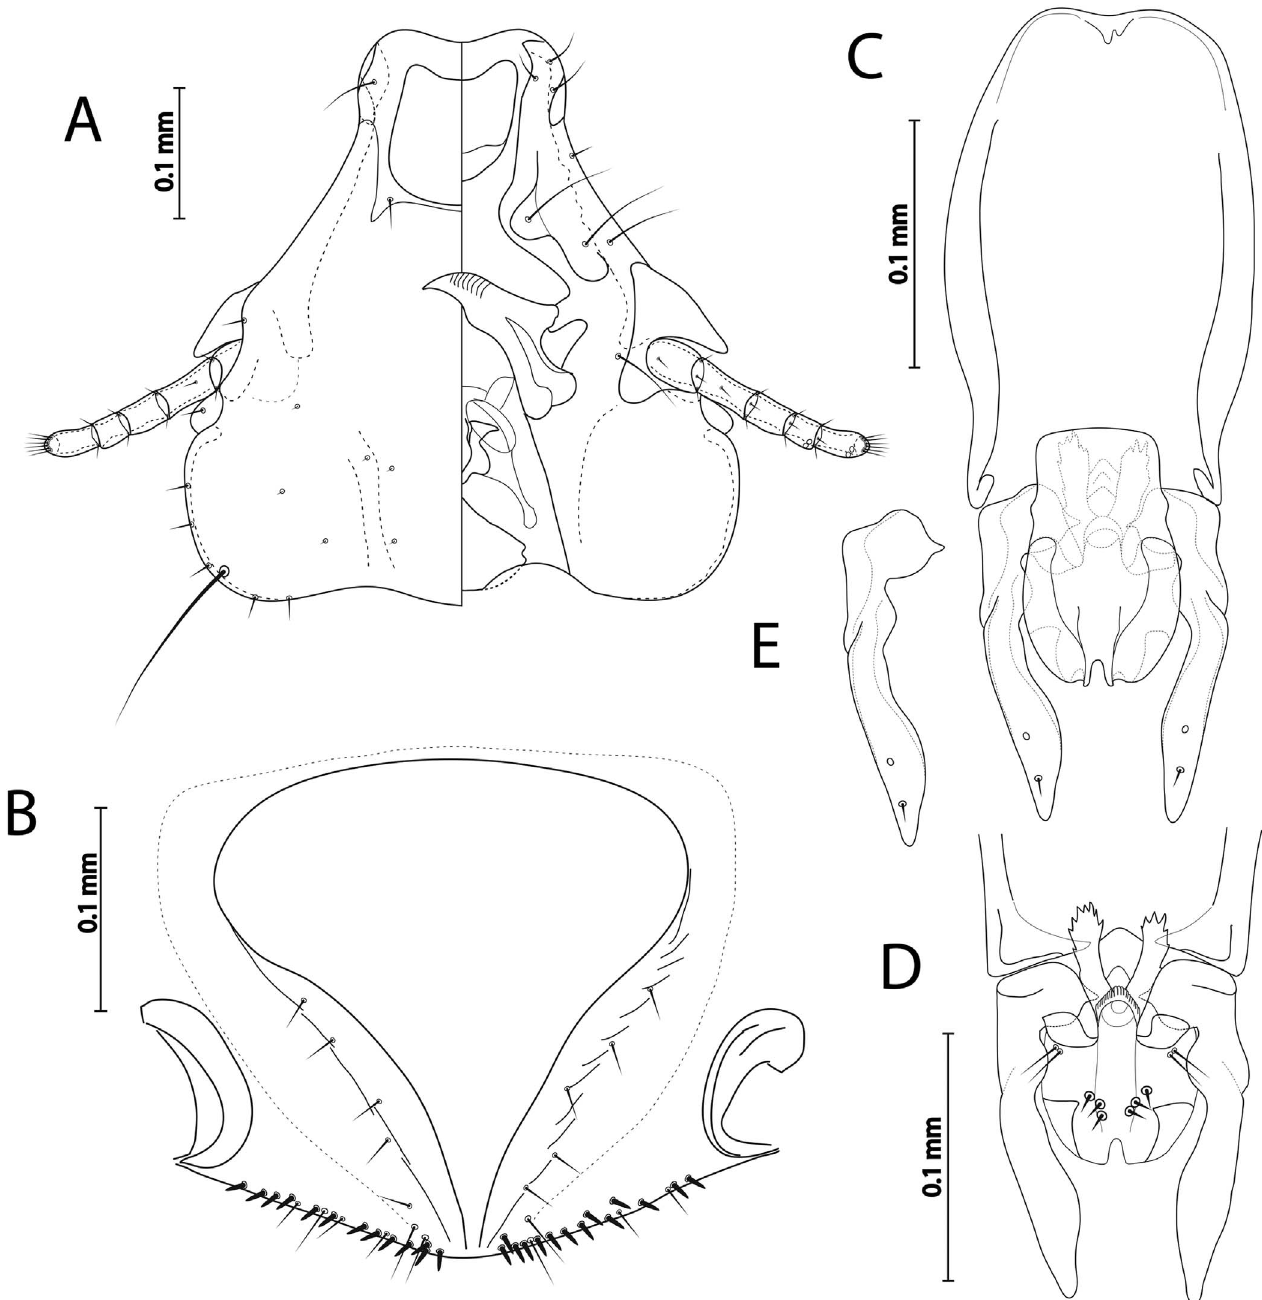
Figure 4. Sturnidoecus ex Turdus merula. (A) Male head dorso-ventral view; (B) Female subgenital plate and vulval margin, ventral view; (C) Male genitalia dorsal view; (D) Male genitalia, ventral view; (E) Male paramere, dorsal